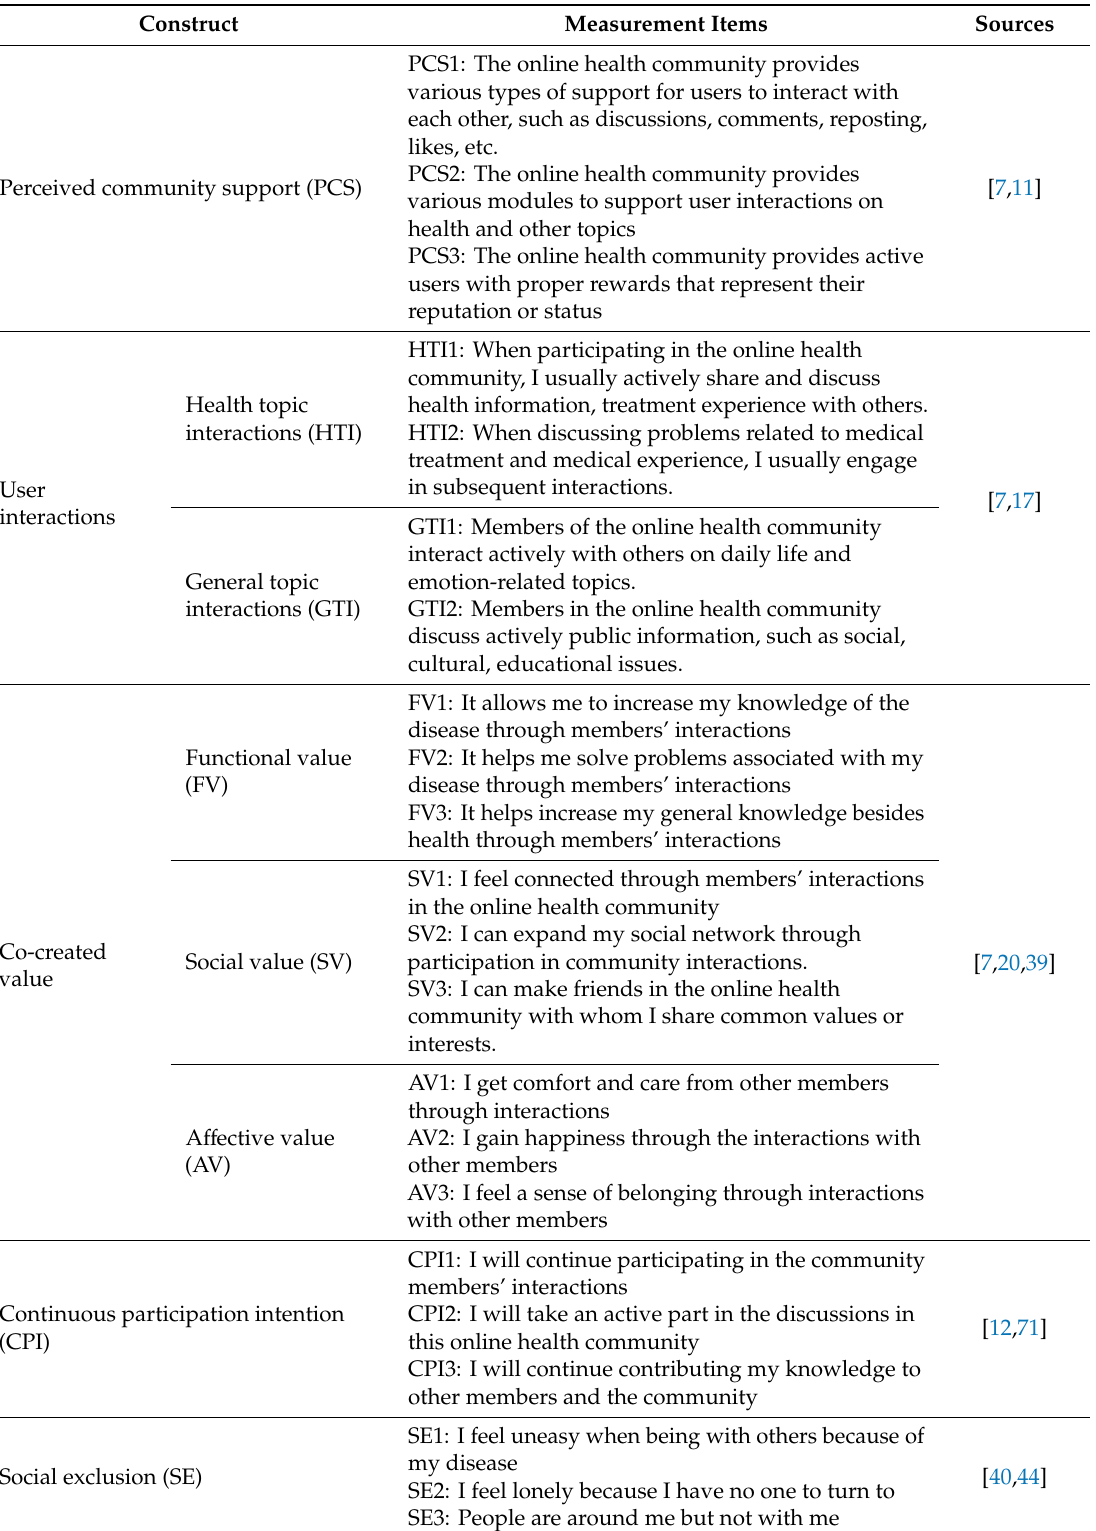
Table 2. Research constructs and